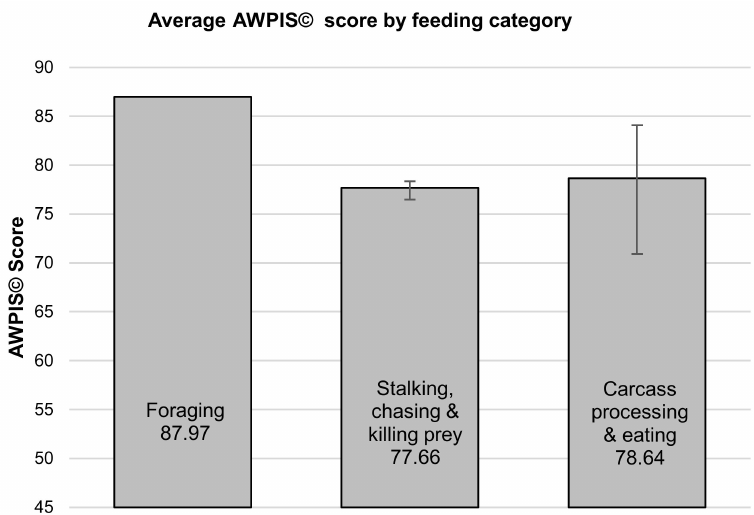
Figure 3. Comparison of group means ± standard error across three categories of priorities linked to the acquisition of food (ANOVA (F(2,3) = 1.617, p =